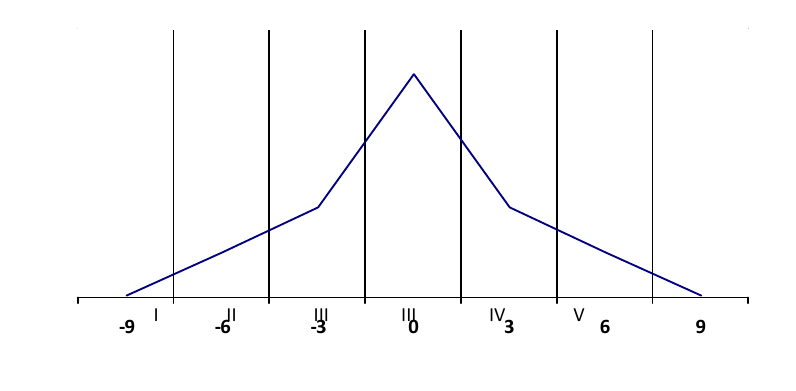
Fig. 1. Histogram of ranked assessment of biological age: I-V -rank. I rank is maximally slowed